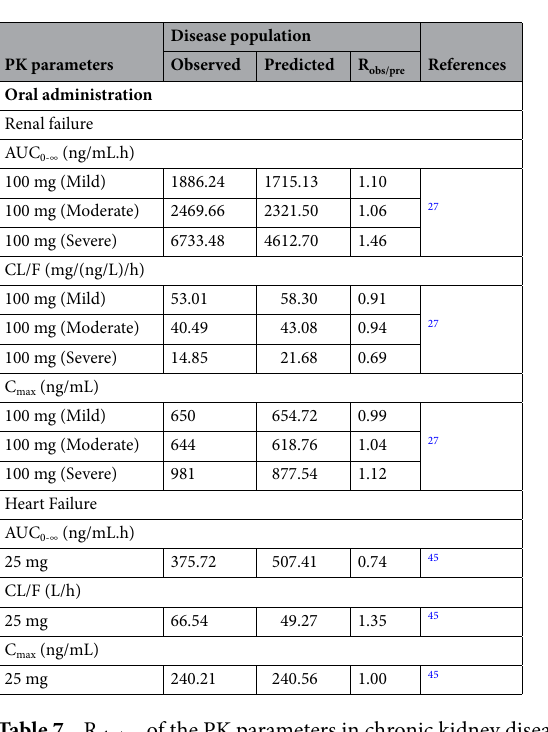
Table 7. R obs/pre of the PK parameters in chronic kidney disease and chronic heart failure populations.